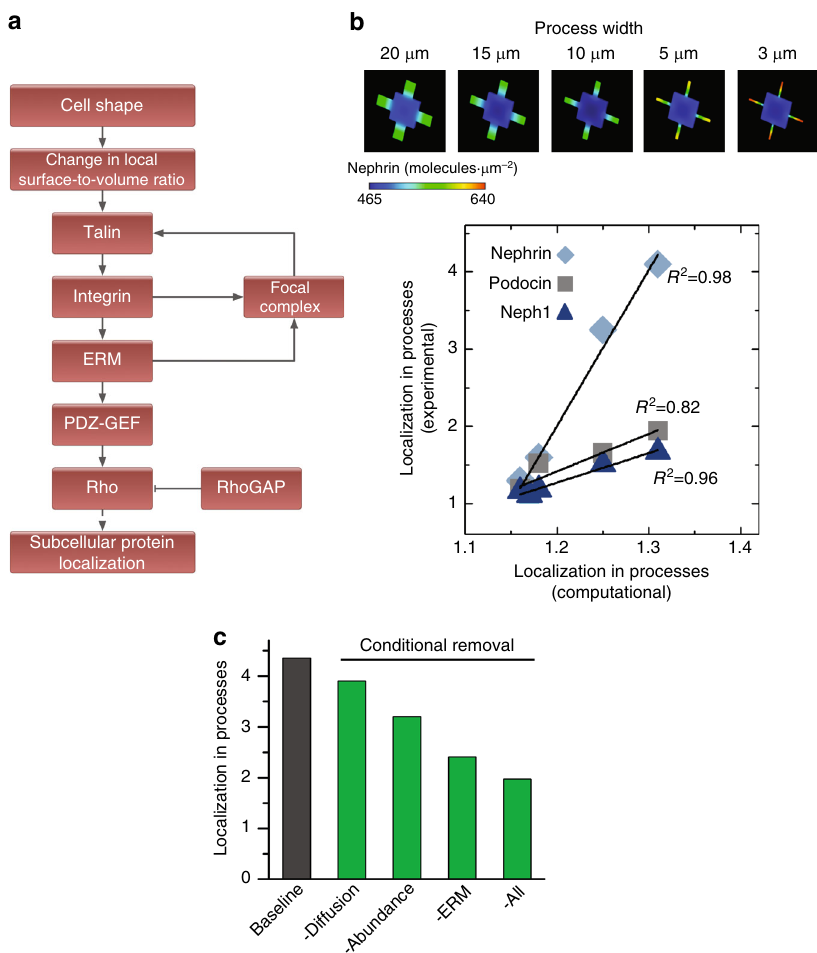
Fig. 7 Intracellular reaction-diffusion dynamics enable shape sensing. a Schematic of the signaling pathway with an ERM-centered positive feedback loop that induces shape-based subcellular localization of proteins in podocytes. b (Top) Simulation results for nephrin localization in 3-D podocytes with peripheral processes of different widths. PDE-based dynamical models con fi rm the experimentally observed width-dependent localization of nephrin due to spatially heterogeneous focal adhesion assembly. (Bottom) Correlation between experimental localization of slit diaphragm proteins nephrin, podocin, and neph1 and the computational predictions. c The effect of experimentally measured molecular attributes of integrin β 3 on generation and maintenance of localization phenotype was tested by removing individual molecular properties of integrin β 3 and replacing them with those of integrin β